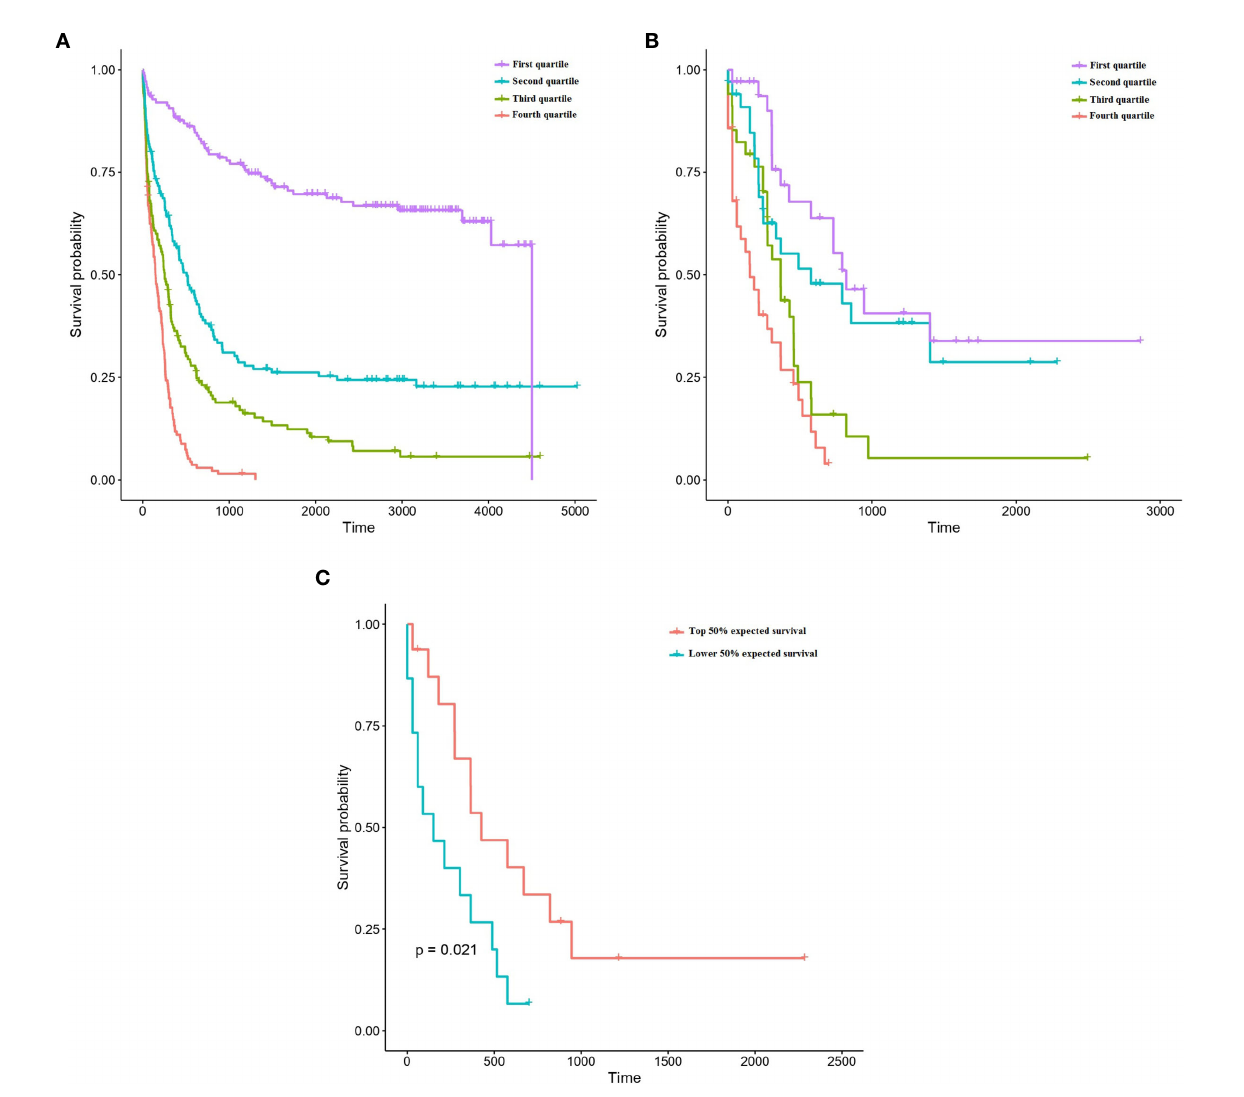
FIGURE 2 | Kaplan-Meyer plots representing the survival of patients depending on their classi fi cation to each quartile of predicted survival by ST-123 in the training (A) and validation (B) cohorts. (C) Kaplan-Meyer plots representing the outcomes of patients affected by high-risk mutations ( TP53 mutation/deletion, ASXL1 mutation or RUNX1 mutation) depending on their classi fi cation to the upper or lower median of predicted mortality by ST-123 in the validation set.